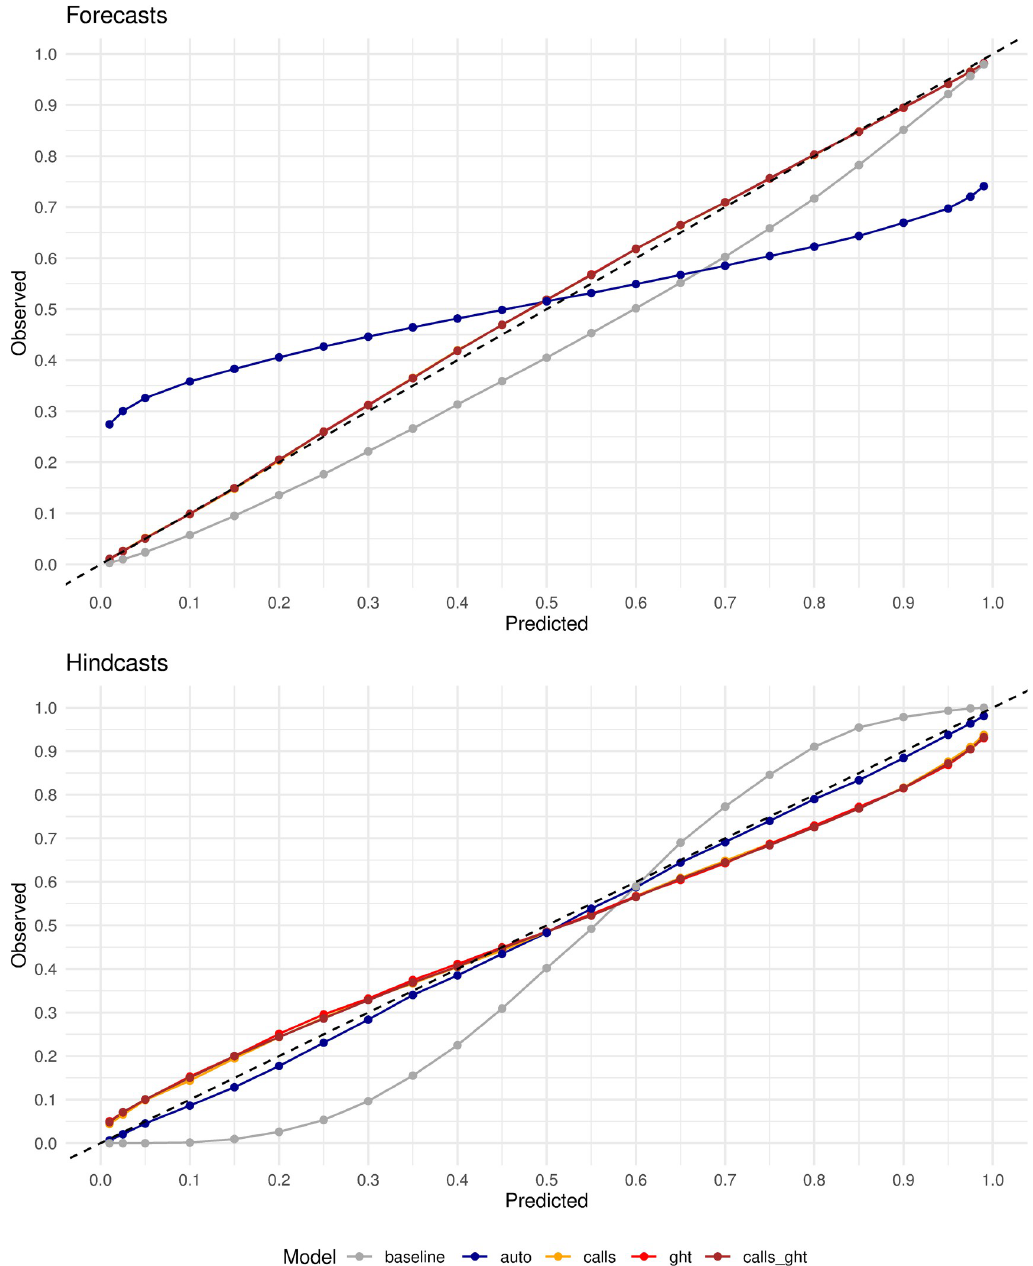
Fig 5. Calibration plot of forecasts (top) and hindcasts (bottom). Forecasts from auto (Cramer’s distance [53]=0.03) and to a lesser degree baseline (0.006) appear to be miscalibrated, while the remaining three models have similar and better calibration (5e-4). On the other hand, hindcasts from auto have the best calibration (7e-4) hindcasts and baseline the least calibrated (.015); the augmented models have similar, good calibration